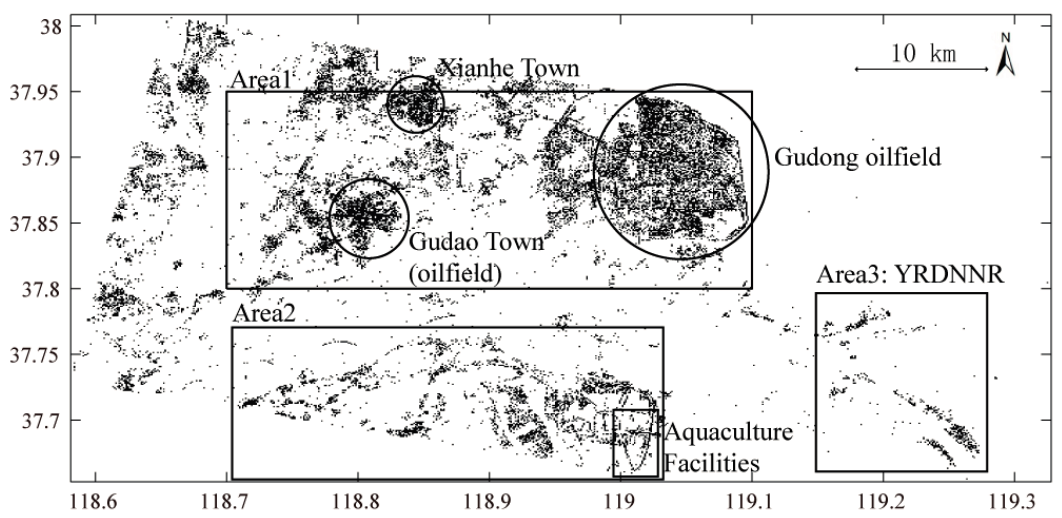
Figure 3. SDFP pixels detected in the Yellow River delta. The SDFP pixels have three clusters: Areas 1, 2, & 3. The Gudao Town (oilfield), the Xianhe Town and the Gudong oilfield to the north of the current Yellow River channel are in Area 1. Aquaculture facilities to the south of current Yellow River channel are found in Area 2. The Yellow River Delta National Natural Reserve (YRDNNR) is in Area 3.